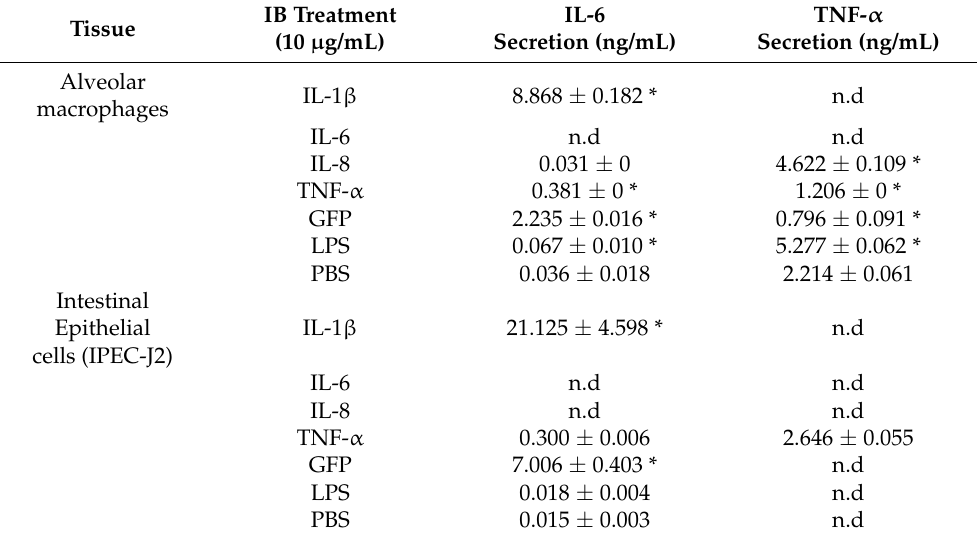
Table 3. Inflammatory response of alveolar macrophages and intestinal epithelial cell line of swine (IPEC-J2). The secretion of IL-6 and TNF- α (ng/mL) was evaluated by ELISA after treatment with 10 µ g/mL cytokine-based IBs containing IL-1 β , IL-6, IL8, or TNF- α . GFP IBs were used as a format control. LPS (10 µ g/mL) and PBS were employed as positive inflammatory control and negative control, respectively. Means and standard error of the mean (SEM) from nontransformed data are represented. Asterisks depict significant differences from PBS control; p < 0.0001; n.d: nondetected. IB Treatment IL-6 TNF- α Tissue (10 µ g/mL) Secretion (ng/mL) Secretion (ng/mL) Alveolar IL-1 β 8.868 ± 0.182 * n.d macrophages IL-6 n.d n.d IL-8 0.031 ± 0 4.622 ± 0.109 * TNF- α 0.381 ± 0 * 1.206 ± 0 * GFP 2.235 ± 0.016 * 0.796 ± 0.091 * LPS 0.067 ± 0.010 * 5.277 ± 0.062 * PBS 0.036 ± 0.018 2.214 ± 0.061 Intestinal Epithelial IL-1 β 21.125 ± 4.598 * n.d cells (IPEC-J2) IL-6 n.d n.d IL-8 n.d n.d TNF-